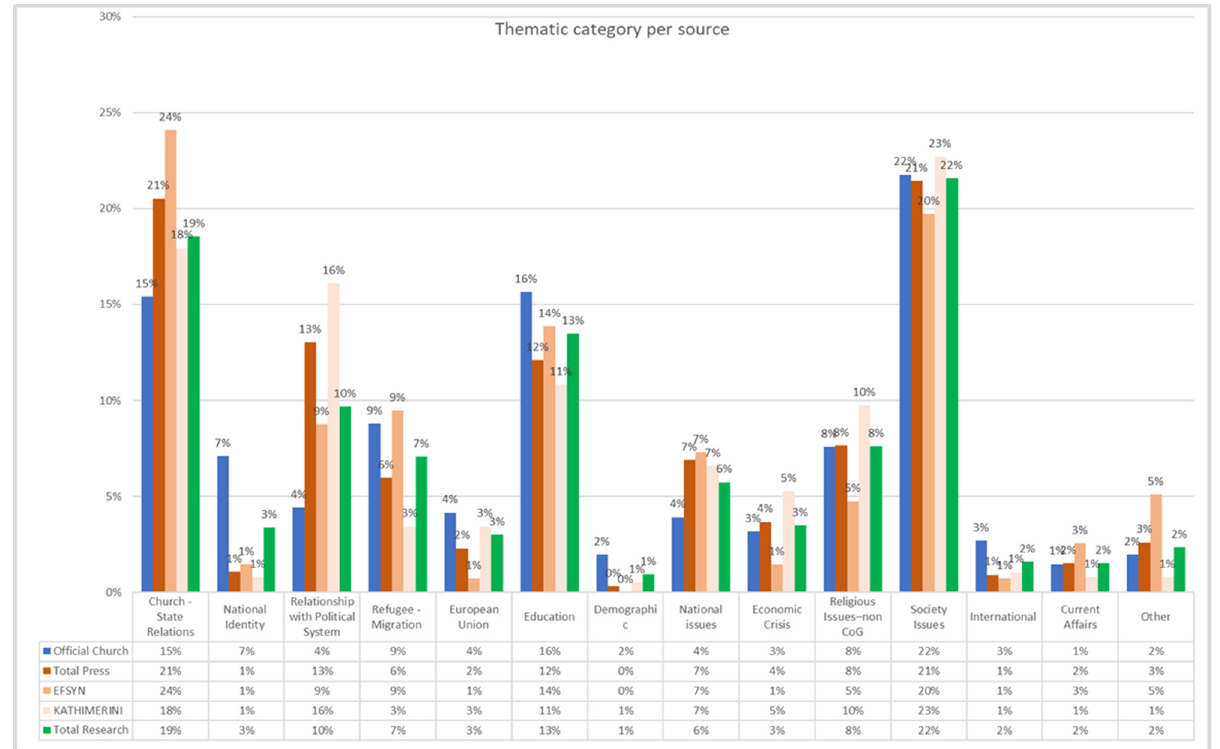
Figure 1. Thematic category per source. Source: Official website of the CoG (www.ecclesia.gr, accessed on 17 March 2022) and newspapers (EFSYN and Kathimerini). Where the height of the bars with the same figures is slightly differentiated, this is due to the value rounding process performed by the statistical program used for the current research (IBM